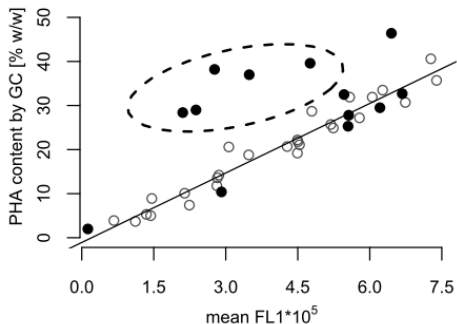
Figure 2. Correlation between poly(hydroxyalkanaote) (PHA) contents determined by gas chromatography (GC) and flow cytometry (FCM). The plot contains PHA content data measured by